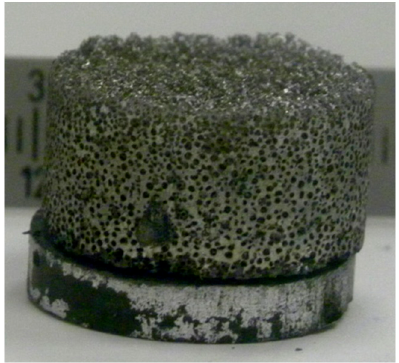
Figure 3. Digital image of a manufactured foam material with 2 cm in height and 2 cm in diameter.